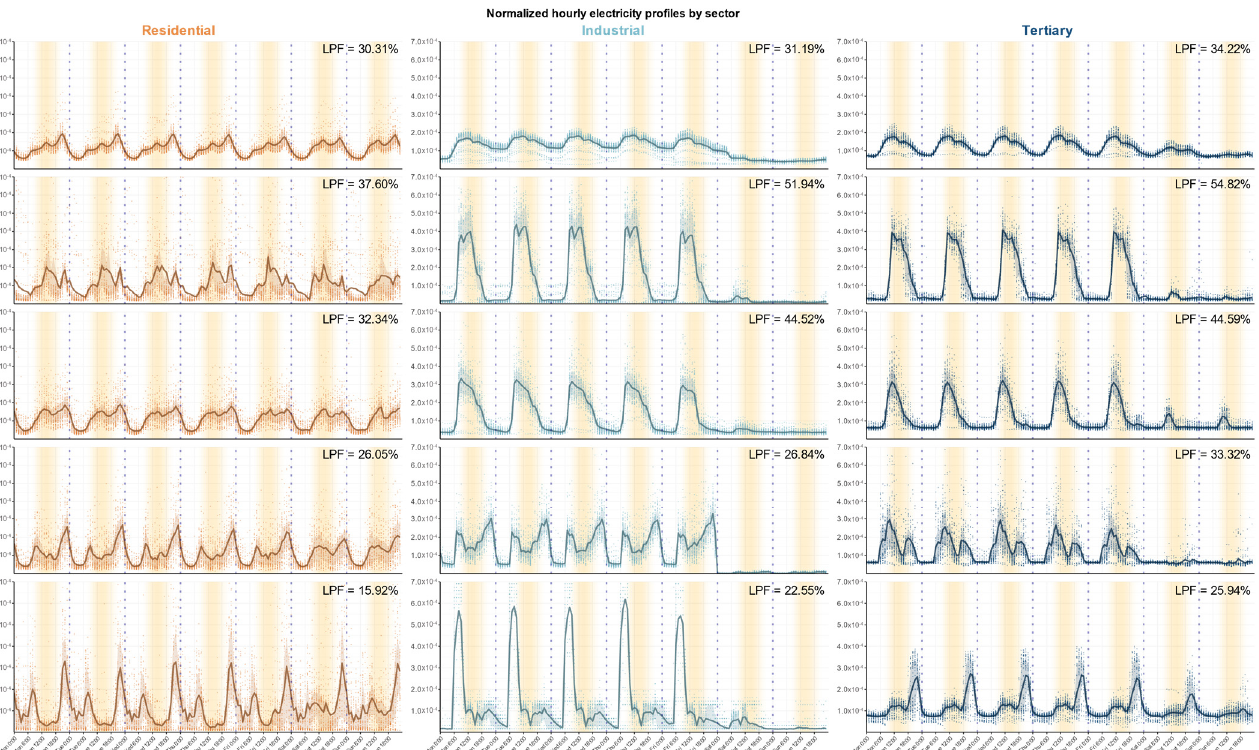
Figure 3. Normalized hourly load profiles of the assessed scenarios and their respective load profile factor.